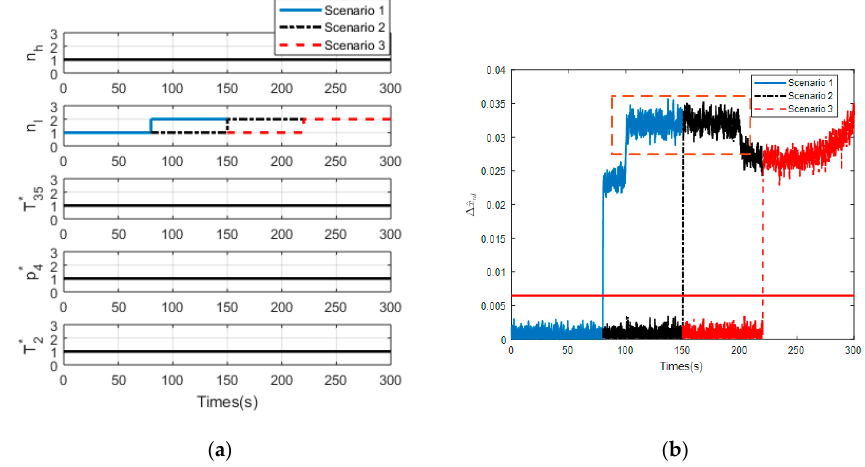
Figure 6. Three scenarios of n l bias fault of ( a ) FDI scheme and ( b ) fault estimation scheme.